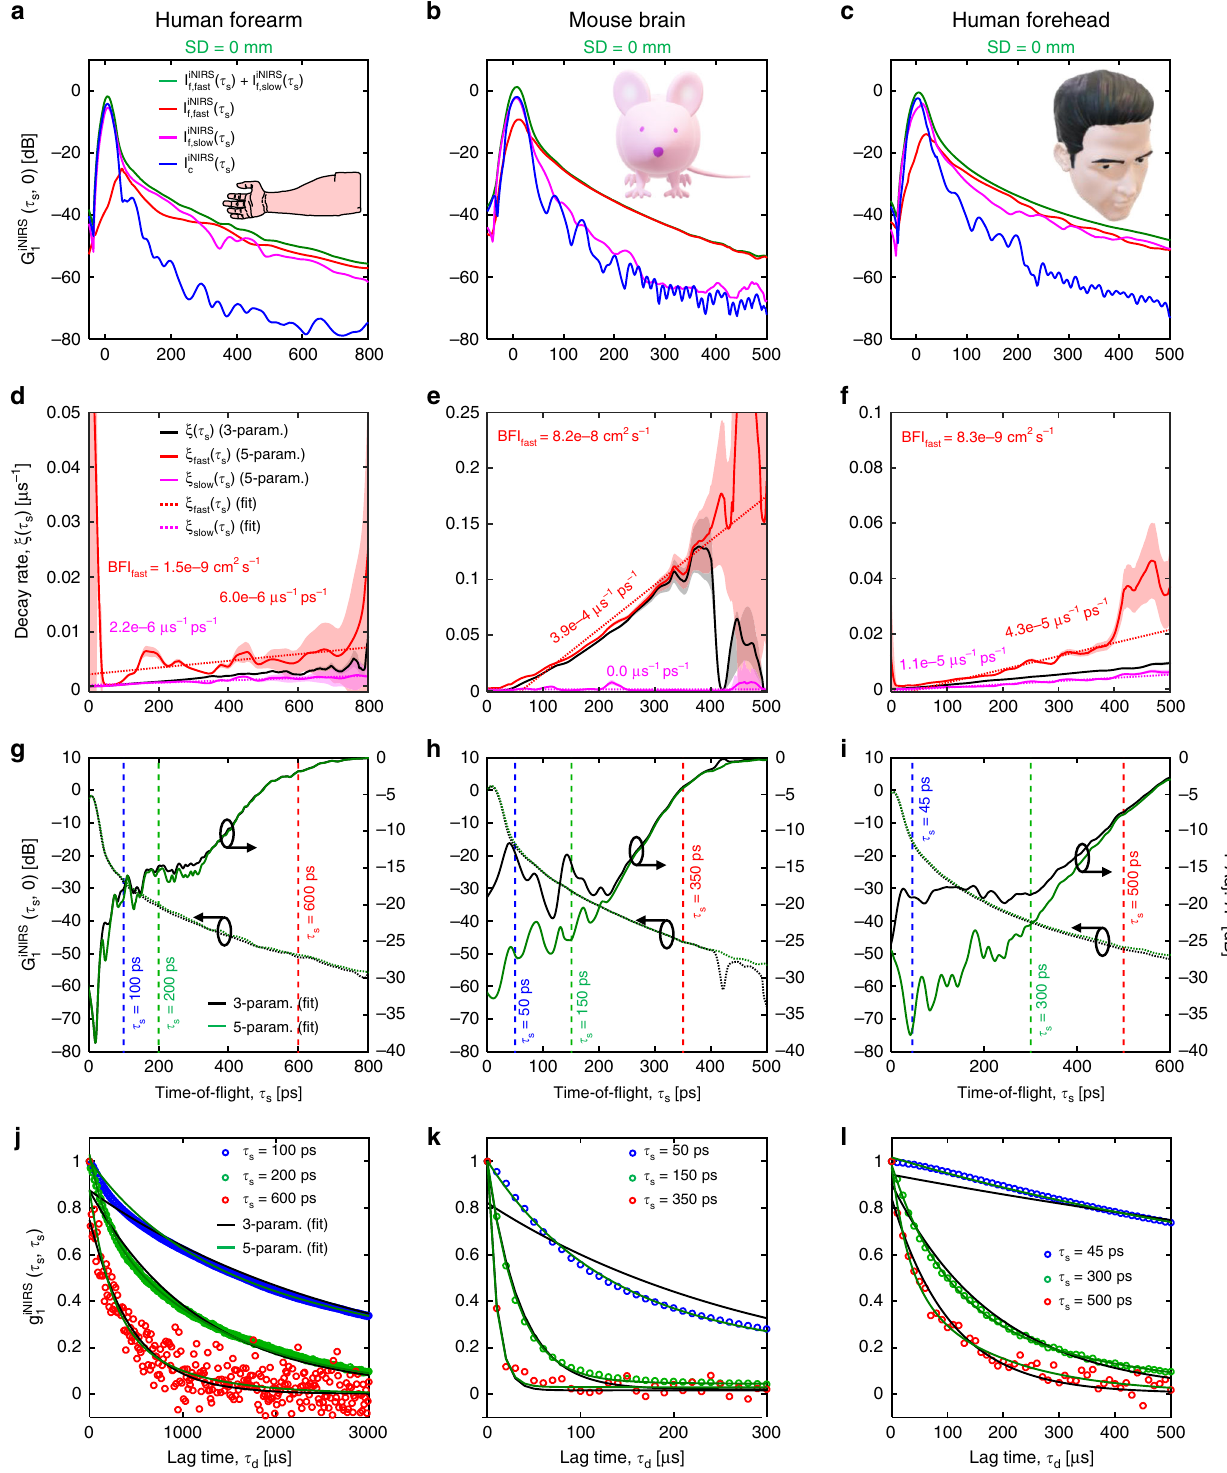
Fig. 4 Bi-exponential model is required to fully describe in vivo measurements. a – c Fitting TOF-resolved fi eld autocorrelations with an empirical bi- exponential 5-parameter model (3 amplitudes, 2 decay rates) reveals the presence of a slow dynamic component. d – f Corresponding TOF-resolved decay rates, and quantitative blood fl ow indices for the fast dynamic component (BFI fast ). Shaded regions represent 95% con fi dence intervals. g – i Adjusted R 2 values support the need for the 5-parameter model to accurately describe iNIRS measurements up to intermediate times of fl ight of 200 – 400 ps, depending on the tissue, beyond which a 3-parameter model suf fi ces (two amplitudes, one decay rate). j – l Exemplary fi eld autocorrelations for selected times of fl ight con fi rm the need for the 5-parameter model up to intermediate TOFs. Note that with more averaging, a 5-parameter model was needed in the human forehead at even later TOFs (Supplementary Fig.